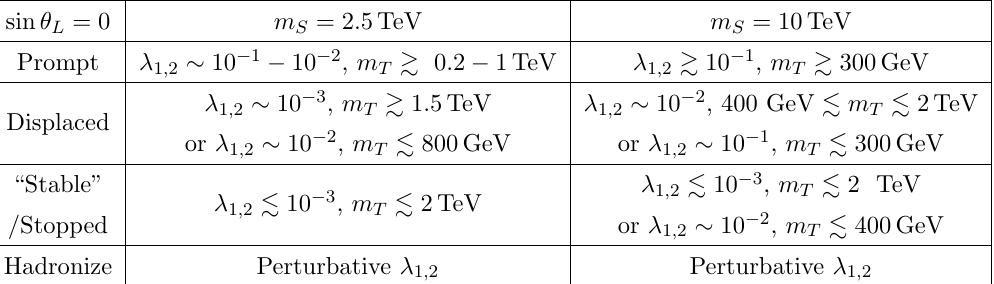
Table 3 . For sin (cid:18) L = 0, Parameter spaces that give us prompt decays, displaced vertices, top partners that are stable on collider time scales, top partners that can stop in the calorimeters, and top partners that